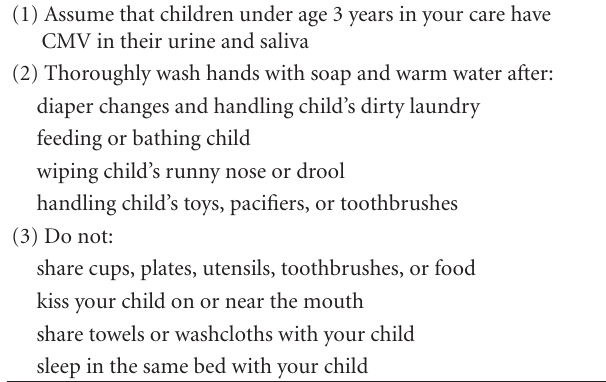
Table 1: Practices for seronegative pregnant women to reduce risk of CMV infection.